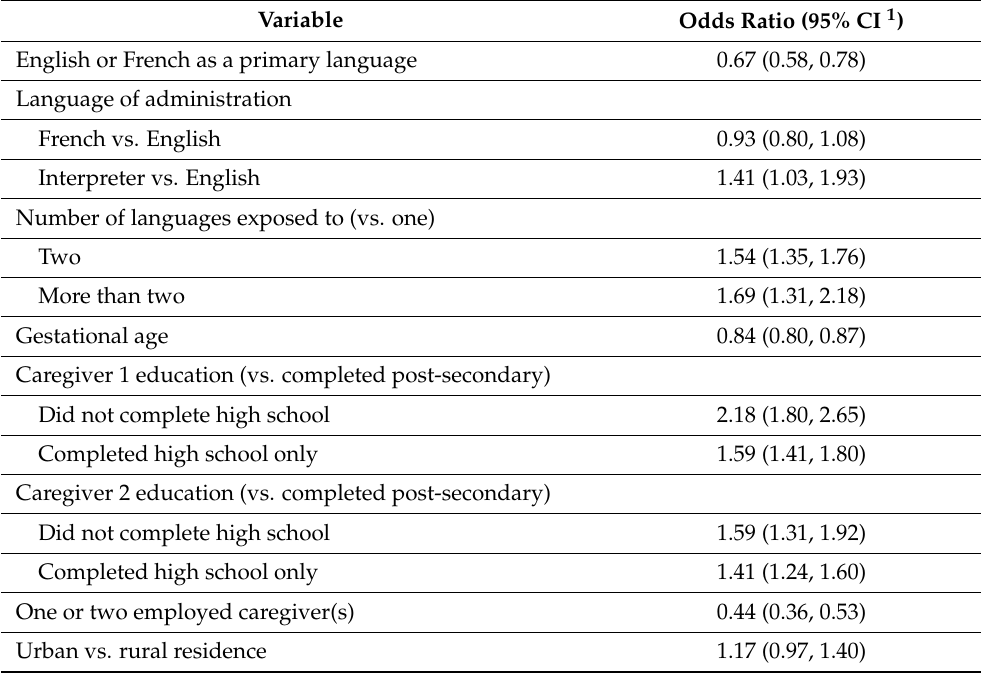
Table 4. Factors affecting odds of Bayley-III Language Composite Scores < 85—univariate analysis.